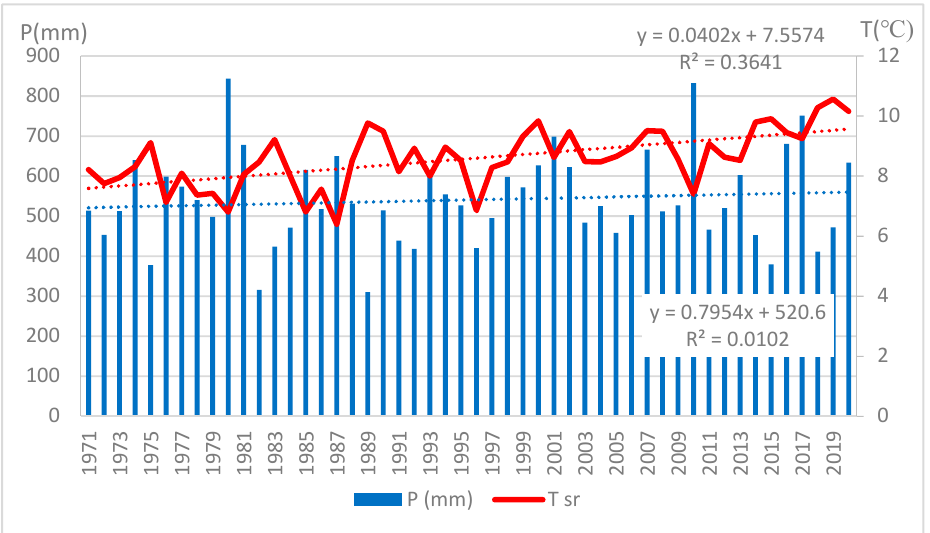
Figure 5. Annual precipitation (P) total and mean annual air temperature (T) recorded at the meteorological station in Toru ń for the period 1971–2020.